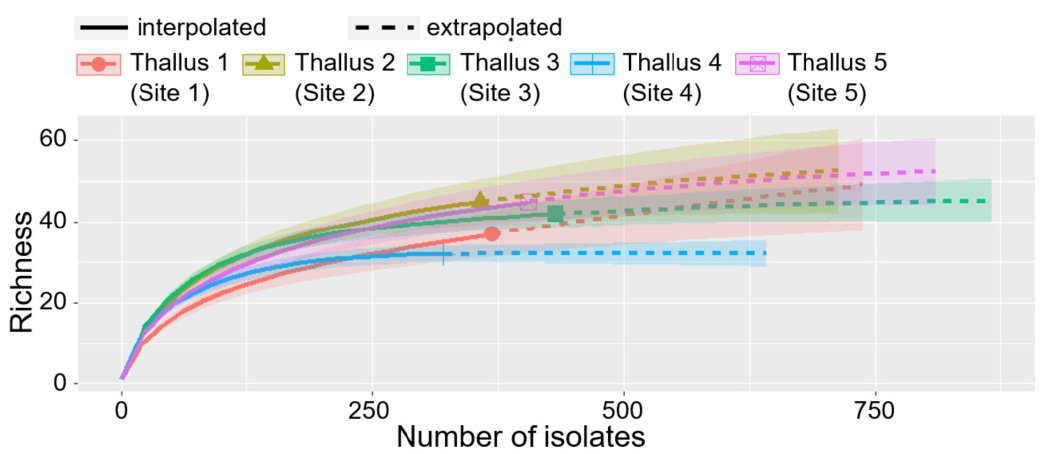
Figure 2. Rarefaction curves with 95% confidence intervals of estimated species richness of isolated ELF community.